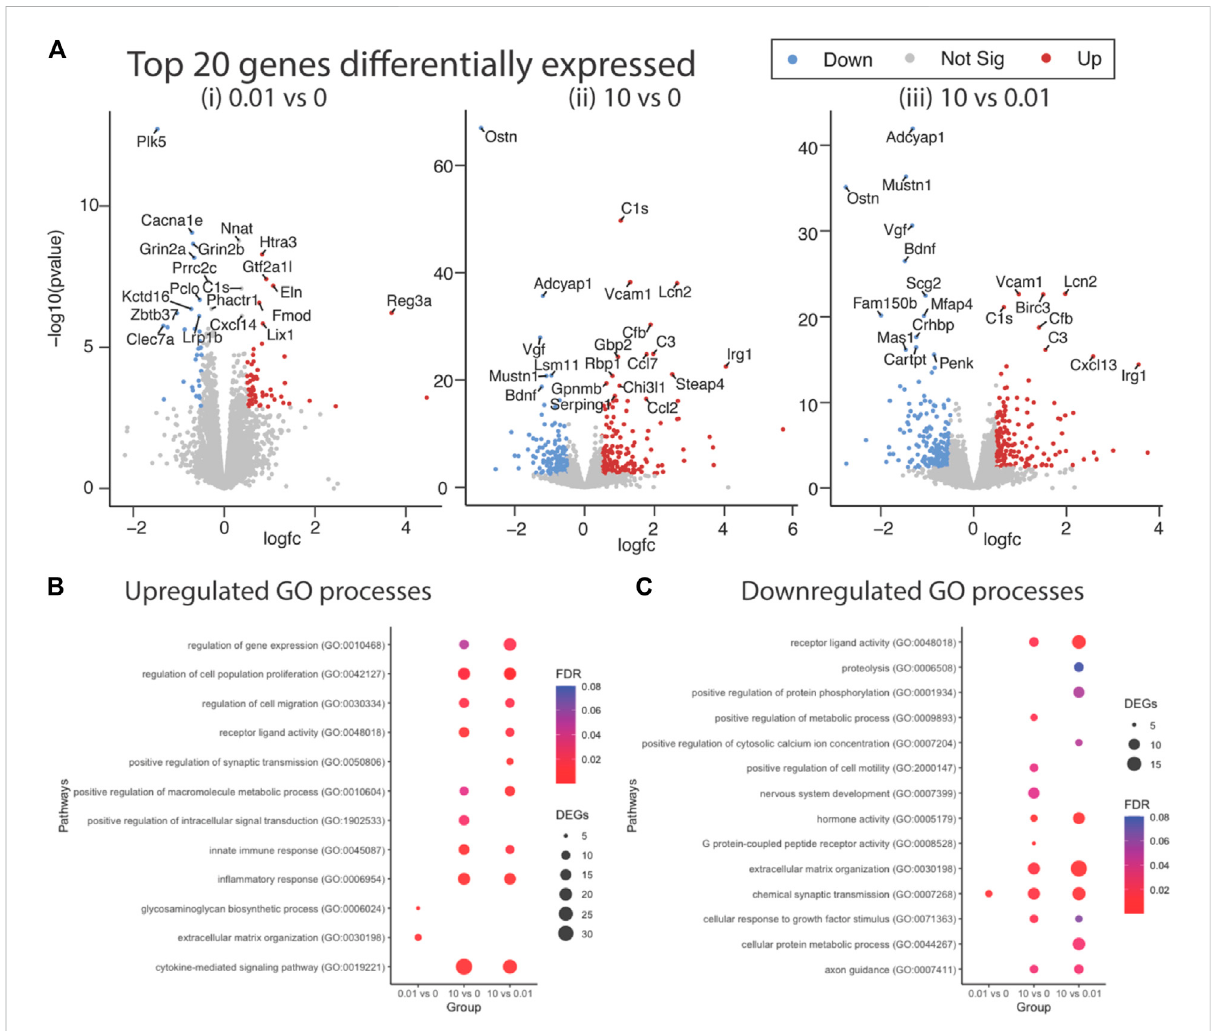
FIGURE 4 Differential gene expression in complex culture following sub-chronic exposure to low versus a high dose of fentanyl. (A) Volcano plots of statistical signi fi cance versus the magnitude of gene expression between treatment conditions: 0.01 vs. 0 μ M fentanyl (i), 10 vs. 0 μ M of fentanyl (ii), and 10 vs. 0.01 μ M (iii) of fentanyl. Top 20 differentially expressed genes (DEGs) are highlighted. Dot plots showing enriched biological process associated with upregulated (B) and downregulated (C) genes. Circle size represents the number of genes in each Gene Ontology (GO) category and the color indicates the false discovery rate associated with each GO